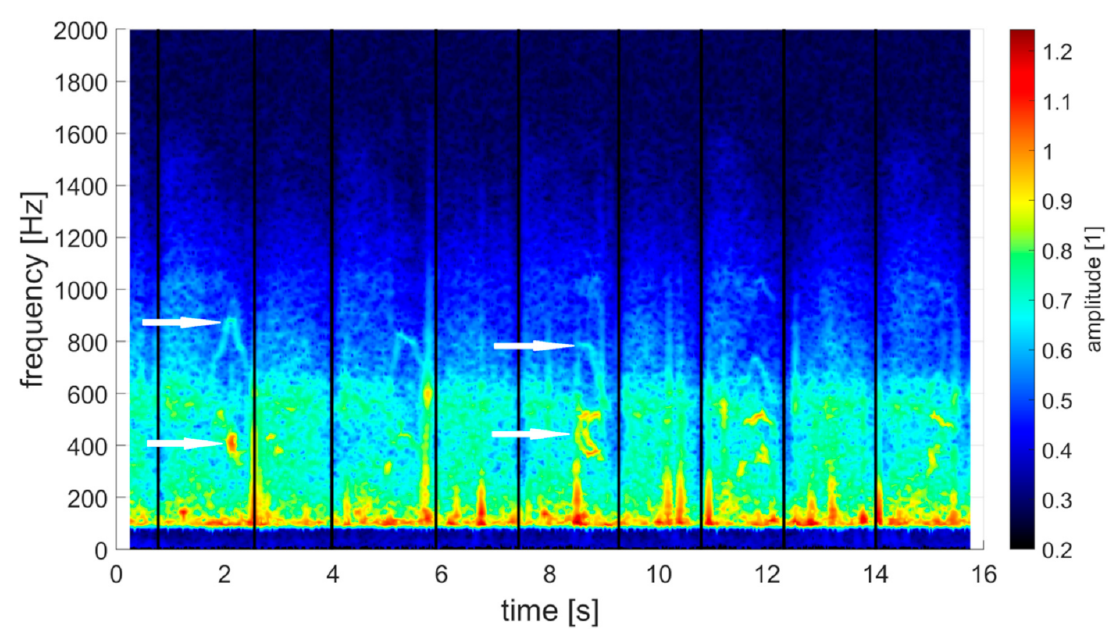
Figure 9. Very chaotic frequency spectrum—Patient No. 2. Recorded at jugulum, age 17 years old, with pronounced bronchial obstruction. The vertical black boarder lines are helpful in this case. In the spectrum the wheezes (areas with sharply increased amplitude—some of them marked by white arrow) are very distinct.